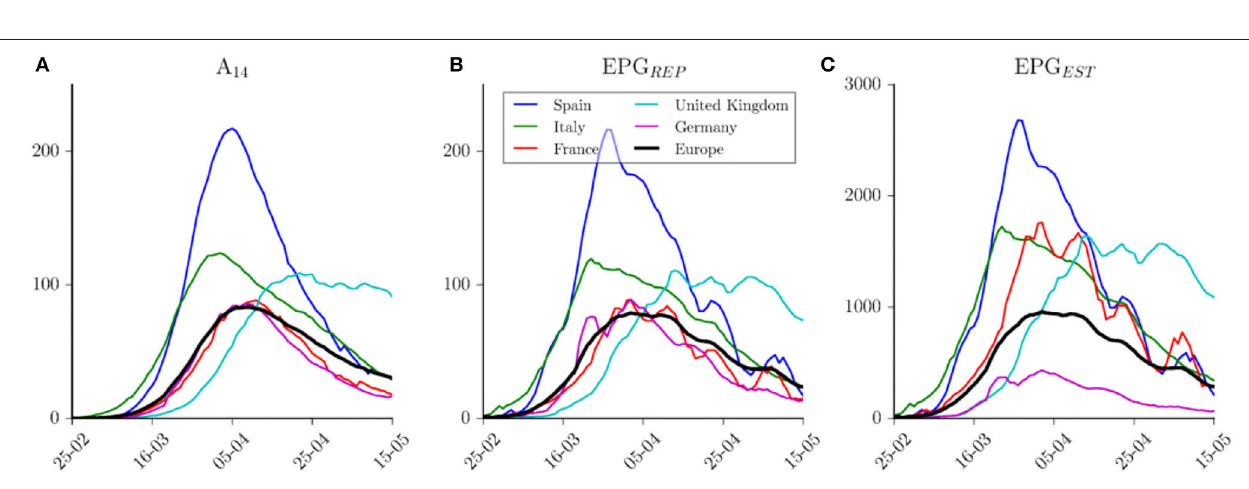
FIGURE 3 | Indices evolution among time. (A) Evolution of reported 14-day attack rate per country. (B) Effective Potential Growth evolution per country computed with reported cases. (C) Effective Potential Growth evolution per country computed with estimated cases. Blue lines for Spain, green for Italy, red for France, cyan for United Kingdom, purple for Germany, and black for Europe. Data were obtained from the European Center for Disease Prevention and Control (24) on May 16,